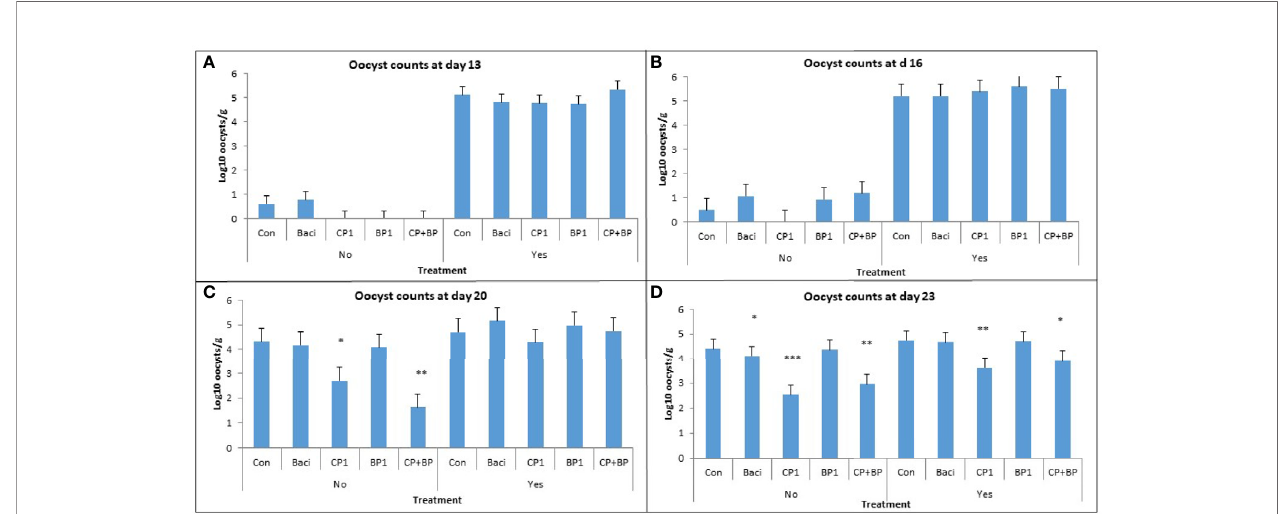
FIGURE 1 | Effects of vaccination and dietary berry pomaces on oocyst counts in intestinal excreta at (A) 13, (B) 16, (C) 20, and (D) 23 days old broilers. Birds not vaccinated (No) and vaccinated (Yes) against coccidiosis; Control, birds fed basal diet; BACI, birds fed basal diet with 55 ppm bacitracin; birds fed basal diet with 55 ppm bacitracin; basal diet supplanted with cranberry pomace 1% (CP1); blueberry pomace 1% (BP1); and cranberry 1% + blueberry 1% pomaces together (CP+BP). * indicate statistically signi fi cant differences (* means P ≤ 0.05; ** means P ≤ 0.01; *** means P ≤ 0.001).